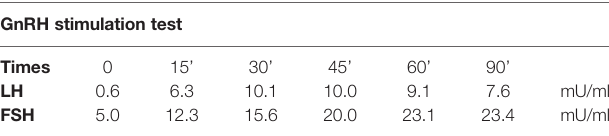
TABLE 1 | Results of the Gonadotropin-Releasing Hormone (GnRH) stimulation test performed at diagnosis of duplication of the pituitary gland (DPG)-plus syndrome in a 5-year-old female.